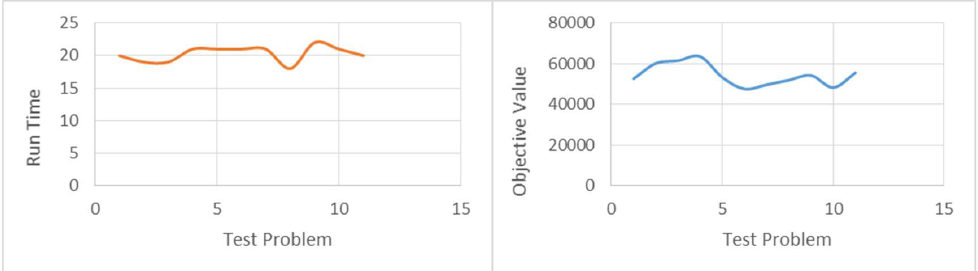
Fig. 12. Objective value and run time for scenario 3